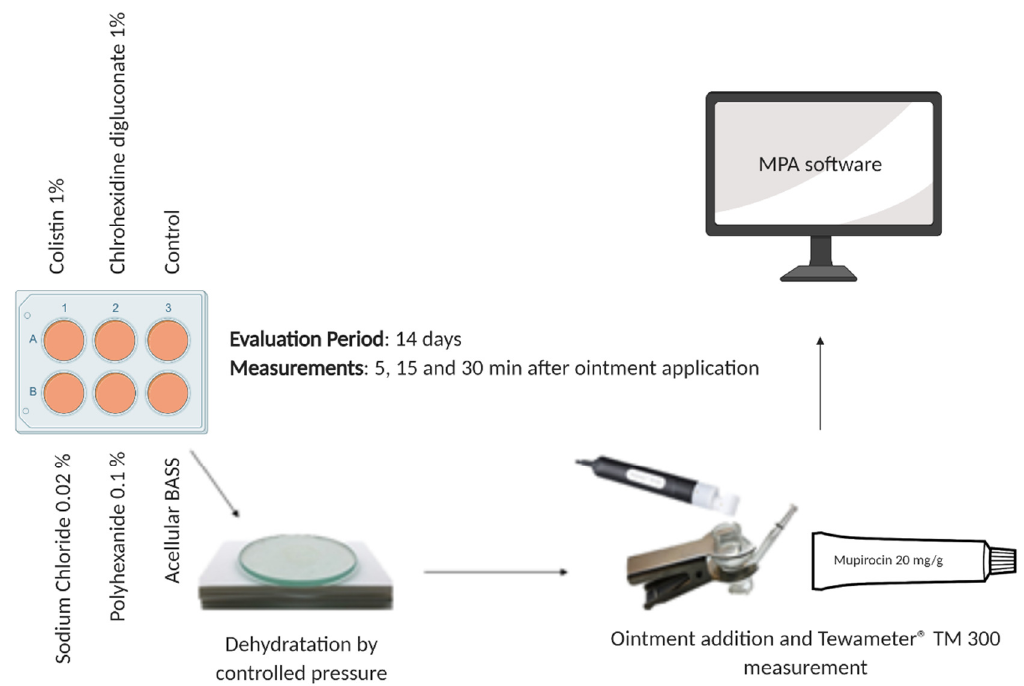
Figure 3. Schematic representation of the trans-epidermal water loss (TEWL) measurement after the antibiotic/antiseptic treatments.